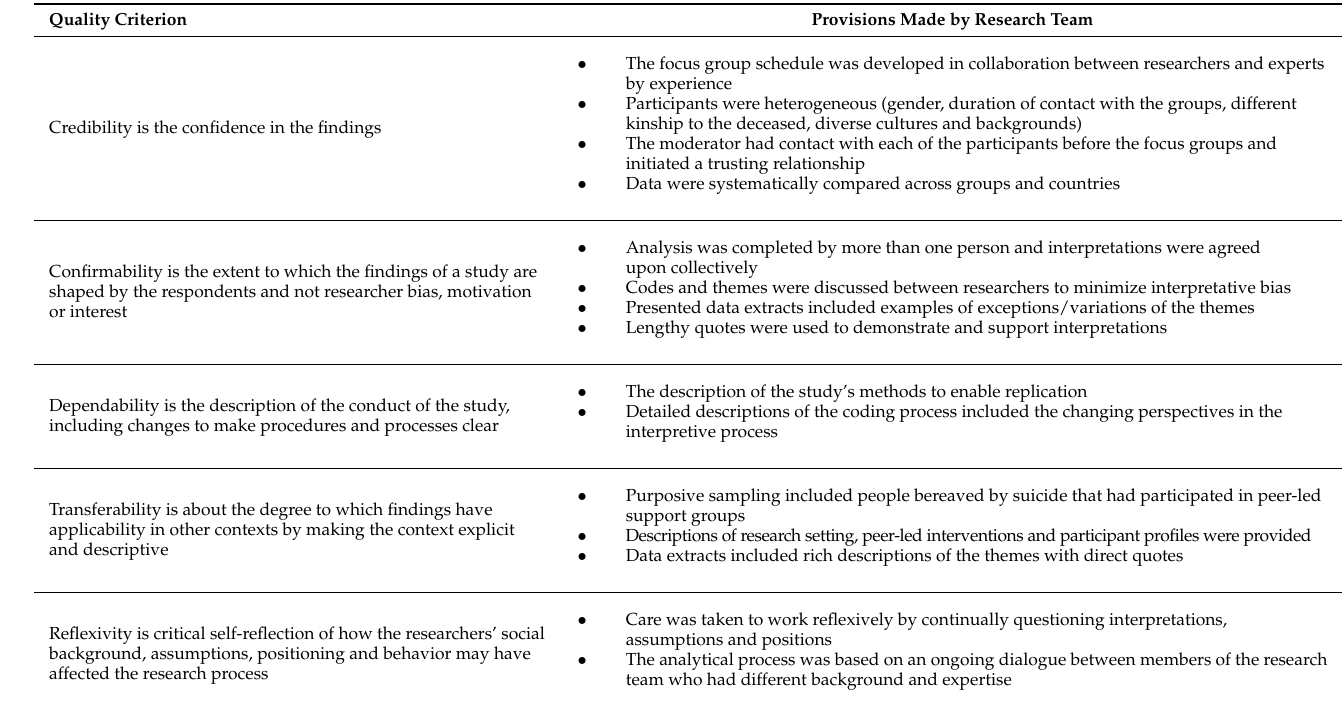
Table 2. Trustworthiness of